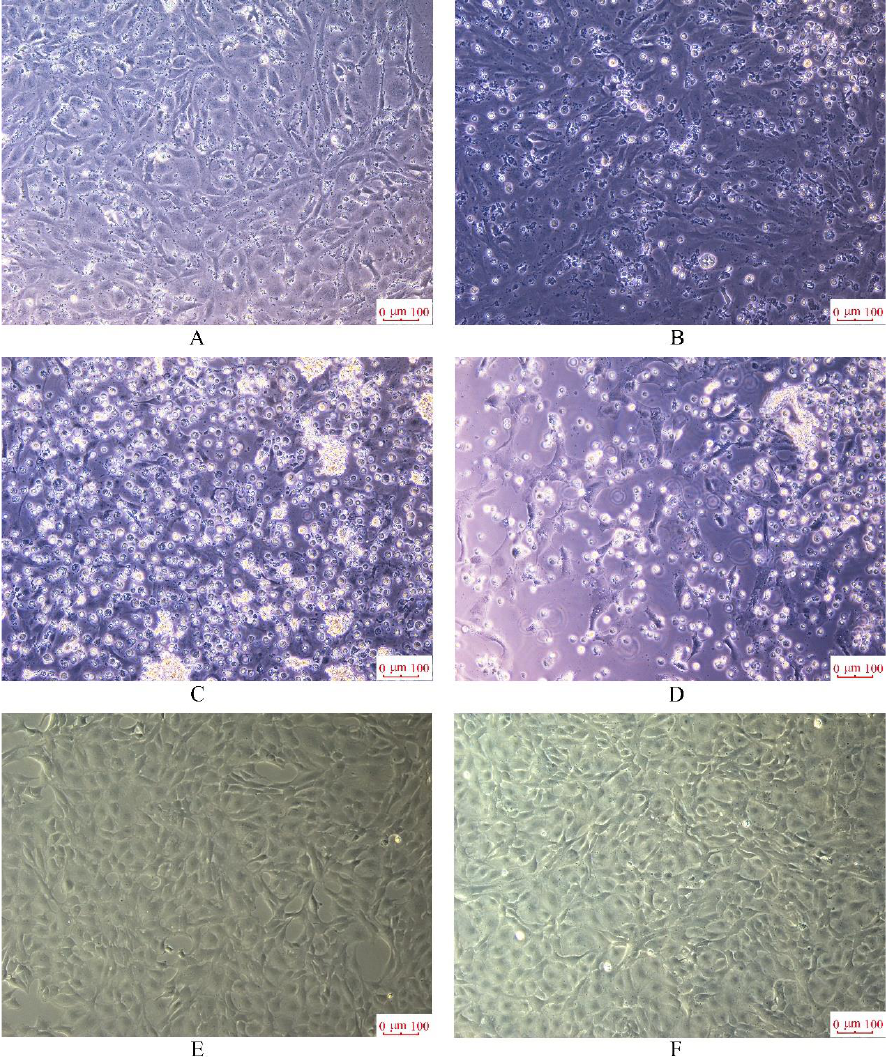
Figure 6. Replication characteristic of CGSIV in TAH-11 cells: ( A ) CPE of TAH-11 cells infected with CGSIV at 12 h p.i; ( B ) CPE of TAH-11 cells infected with CGSIV at 24 h p.i; ( C ) CPE of TAH-11 cells infected with CGSIV at 36 h p.i; ( D ) CPE of TAH-11 cells infected with CGSIV at 48 h p.i; ( E ) L-15 with 10% FBS treatment; ( F ) L-15 without 10% FBS treatment. Scale bar = 100 μm.